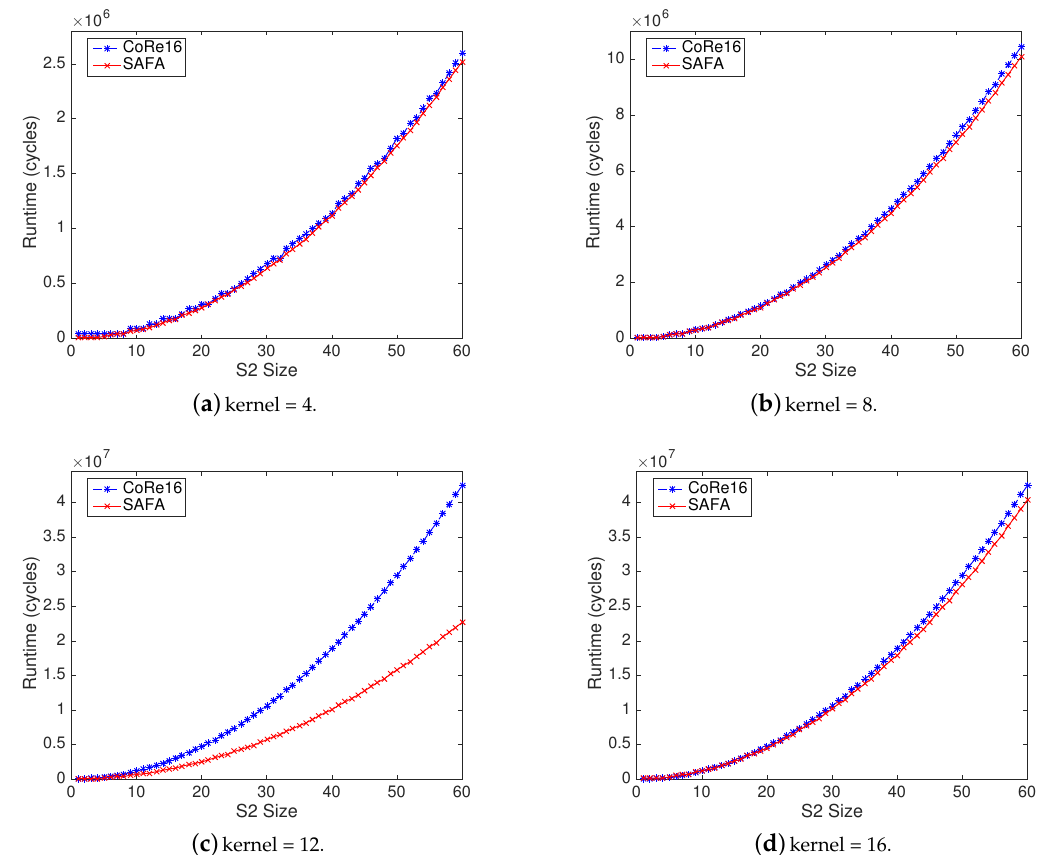
Figure 5. Effects of S2 size on the runtimes of SAFA and CoRe16 under different kernel sizes. The runtimes of SAFA and CoRe16 increase with exponential rates.